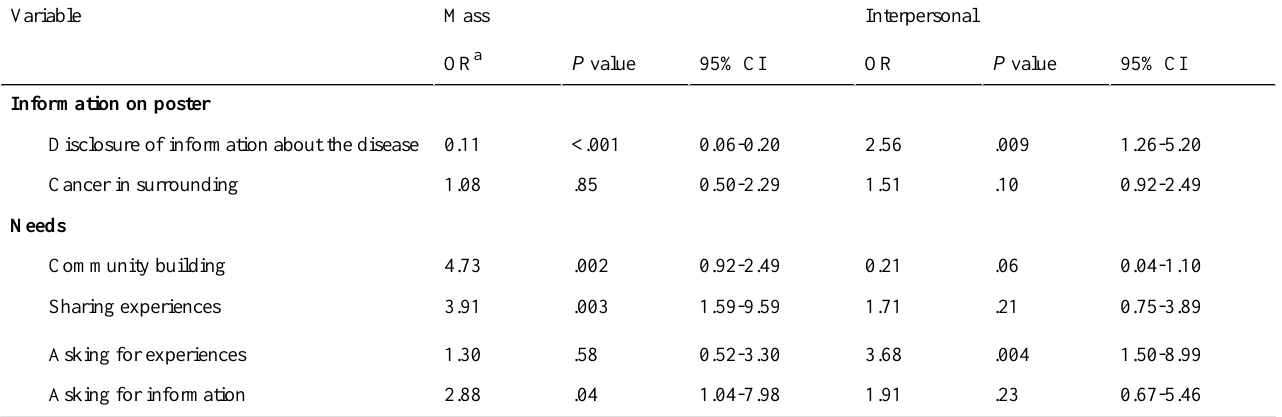
Table 3. Differences between posts containing signs of convergence and posts without (reference category=no media).